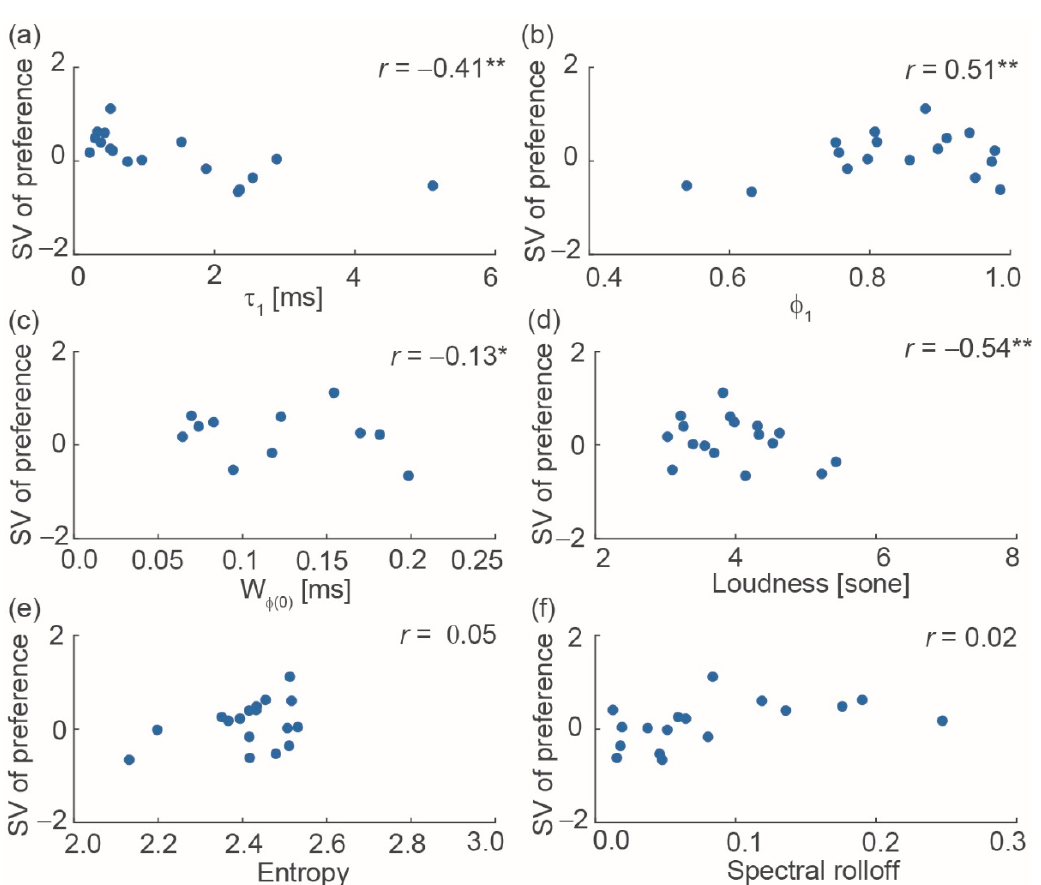
Figure 6. Relationships between physical parameters and scale values of preference for birdsong stimuli. ( a ) τ 1 , ( b ) φ 1 , ( c ) W φ (0) , ( d ) loudness, ( e ) entropy, and ( f ) spectral rolloff. The numbers represent correlation coefficient values. Asterisks represent the level of significance, i.e., ** p < 0.01, * p < 0.05.